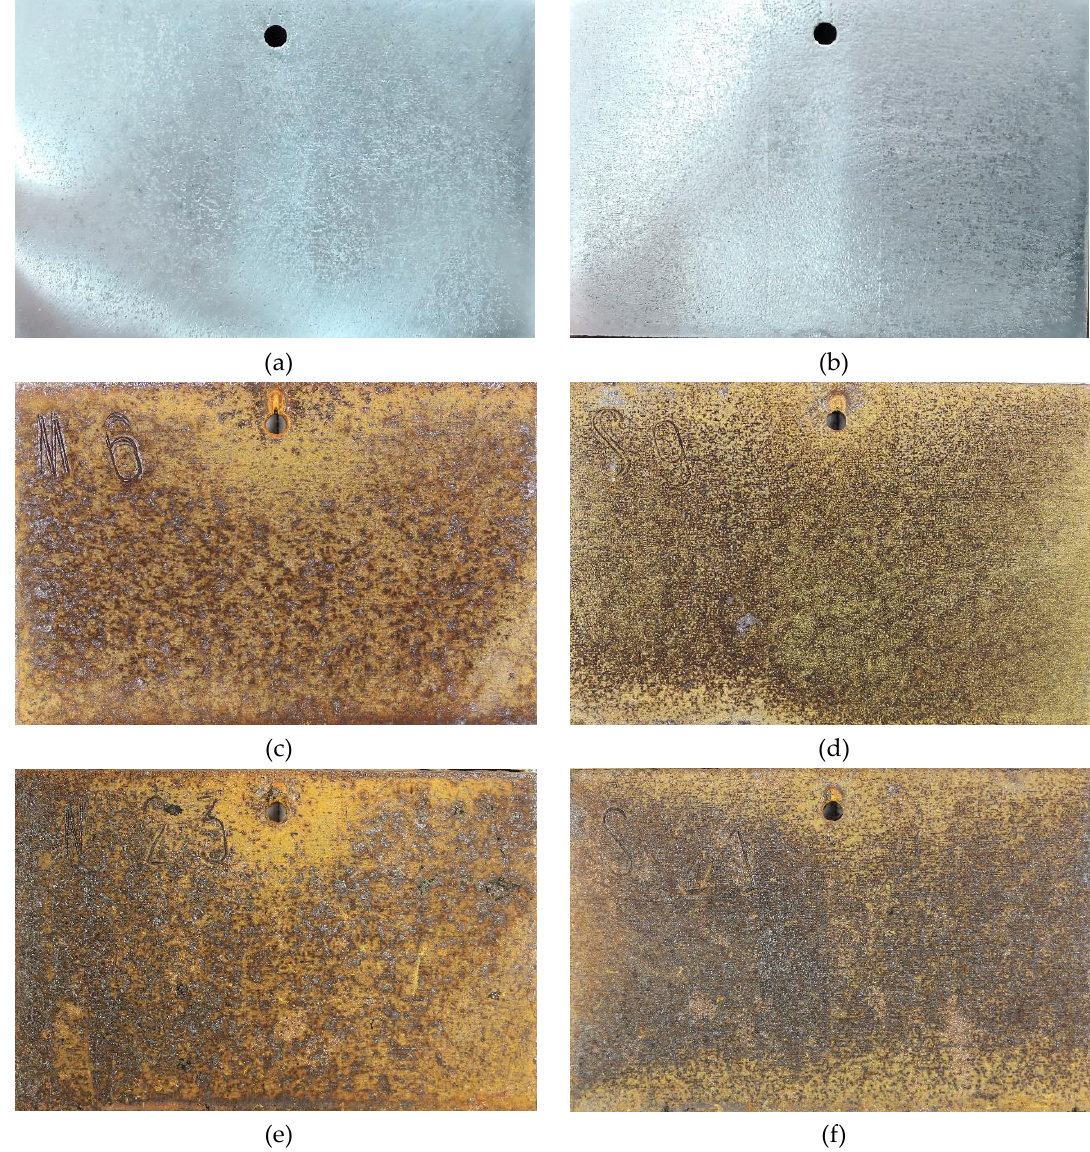
Figure 3. Surface morphology of SMA490BW steel ( a ) as prepared, ( c ) at 75 h, ( e ) at 150 h, and welded joints ( b ) as prepared, ( d ) at 75 h, ( f ) at 150 h, after the periodic immersion wet / dry cyclic corrosion test.